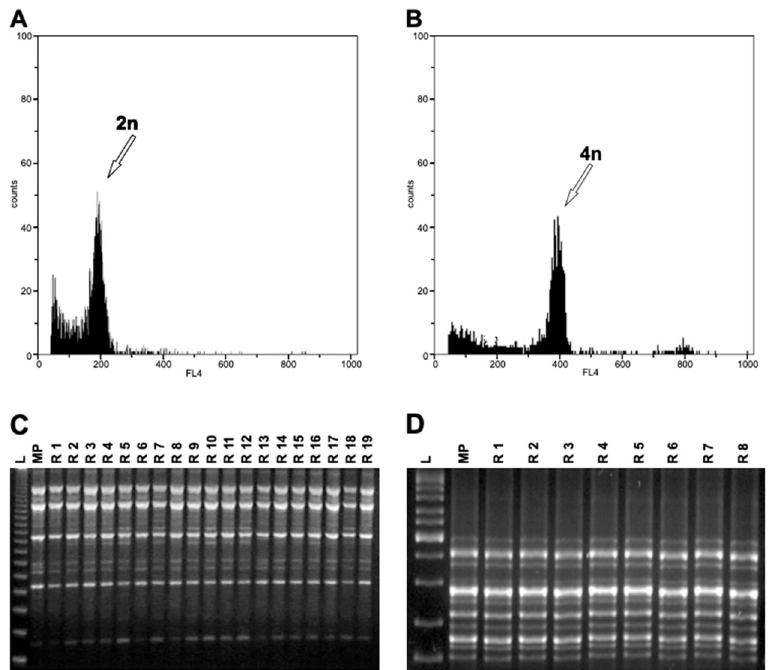
Figure 2. Ploidy level and genetic stability of regenerants through flow cytometric analysis and ISSR markers. Representative flow cytometric histograms of nuclei isolated from leaves of diploid (( A ) = event 51) and tetraploid plants (( B ) = event 34). Histograms showed the fluorescence intensity of diploids on channel 200 and that of tetraploids on channel 400. The data were obtained with the same instrument setting. The gain was positioned on channel 200 for diploid nuclei, while tetraploid nuclei peak appeared on channel 400. ( C ) DNA profiles of ‘Frappato’ regenerants amplified with the RAPD primer OPAT-14. L, ladder 123-bp; MP, mother plant; R 1–19, in vitro regenerants. ( D ) Genetic